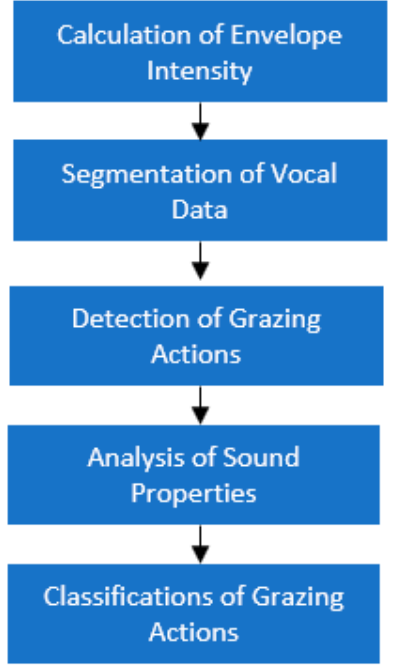
Figure 18. Flow chart of sound signal processing.